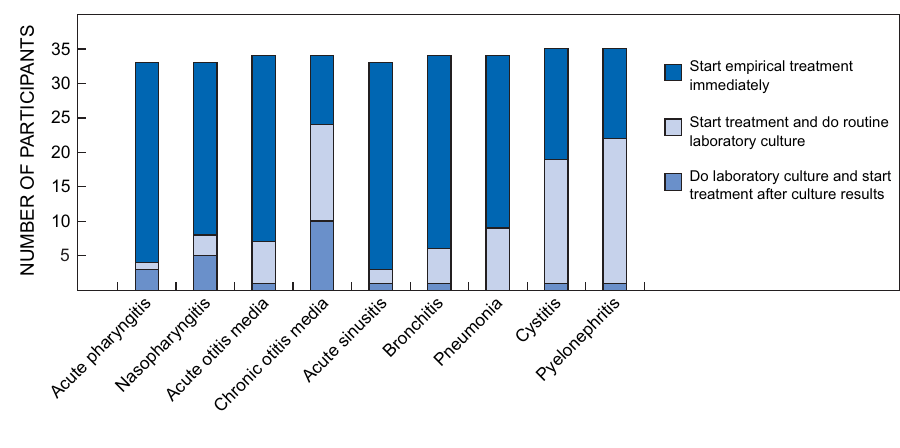
Figure 1: Practice in treating common infections